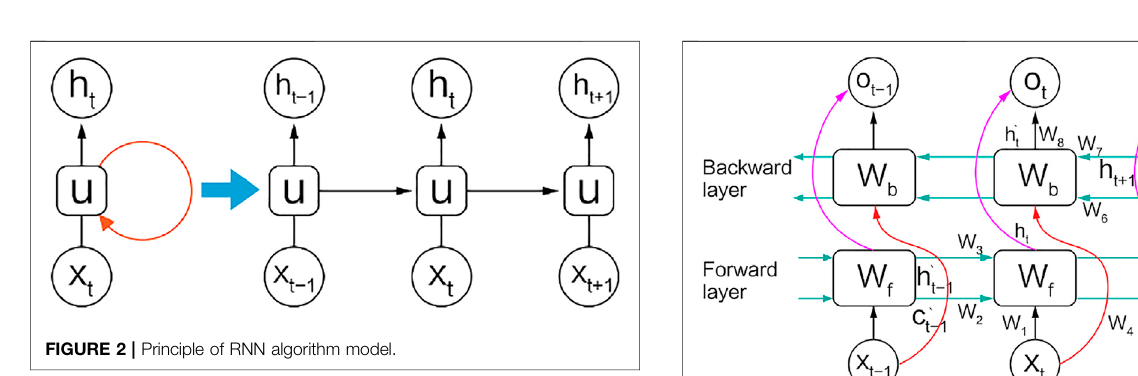
FIGURE 2 | Principle of RNN algorithm model.